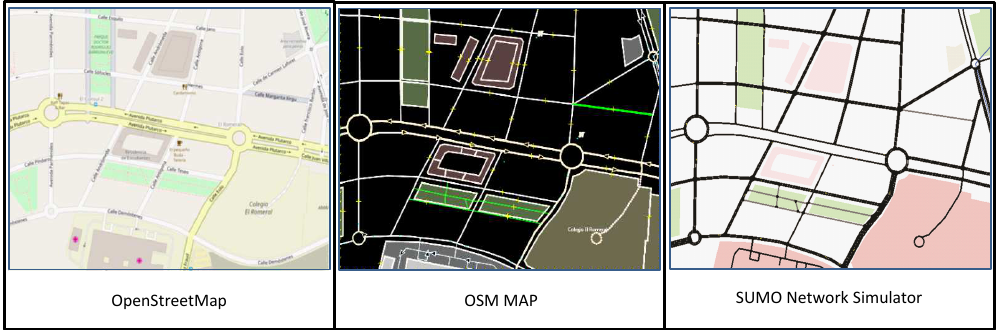
Figure 5. Conversion the Realistic Road Map to Traffic Mobility.